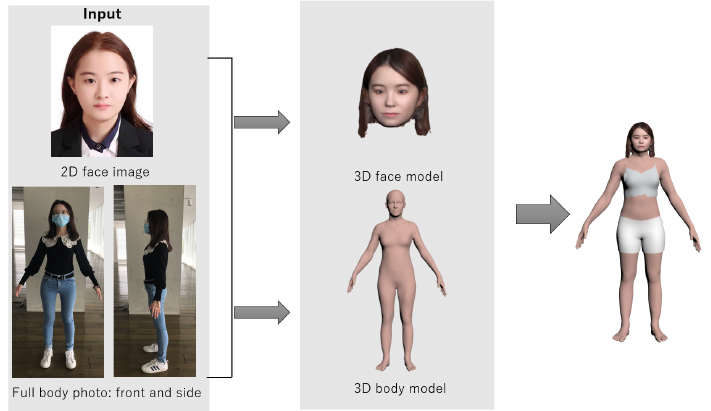
Figure 2. Our system uses three elements as inputs: a single full-front face image and two full body photos (front and side), then we generated a personalized avatar for each user.